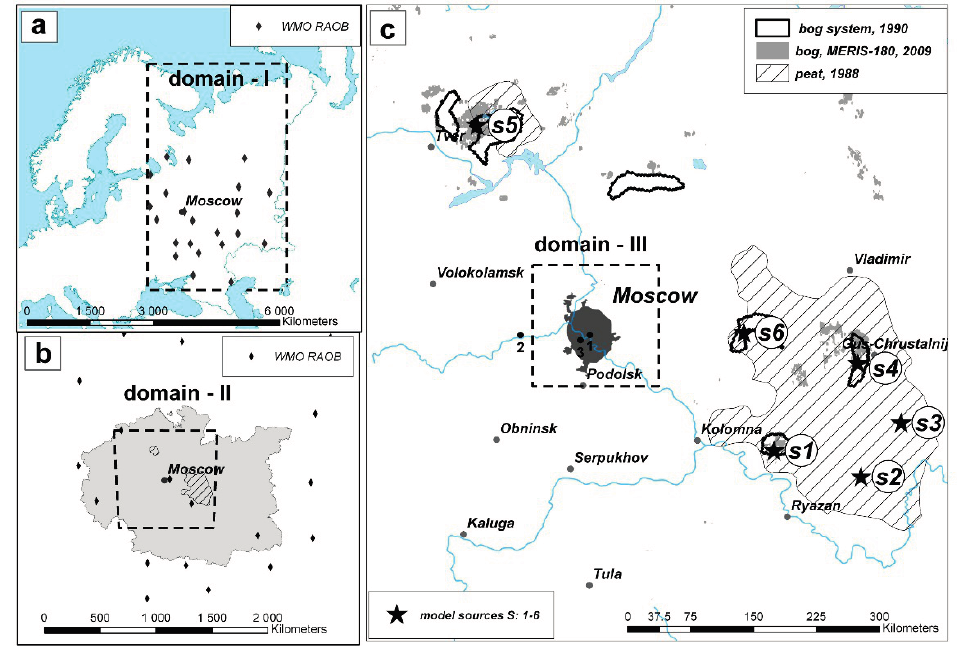
Figure 1. Three Regional Atmospheric Modeling System (RAMS) domains are shown in ( a ), ( b) and ( c ) frames. The outer counter (grey area) around of Moscow is corresponded to area with the intensive wildfires (b). The locations of 22 WMO upper air stations (WMO RAOB) are shown in (a,b). The bog system and peat are in the central part of Russian plain (c). The three scientific stations are shown: 1—OIPA, 2—MSU, 3—ZSS (c). The major places of localization peat wildfires are specified in (c) as s1–s5